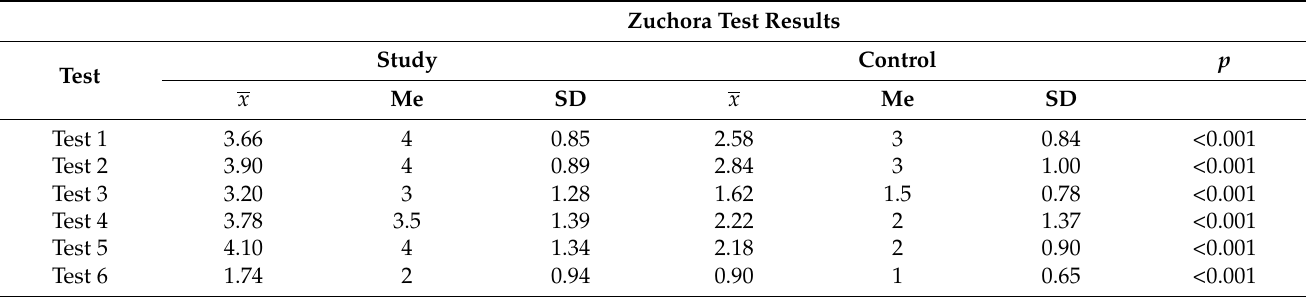
Table 6. Comparisons of the results obtained in individual attempts of the Zuchora test between the study and control